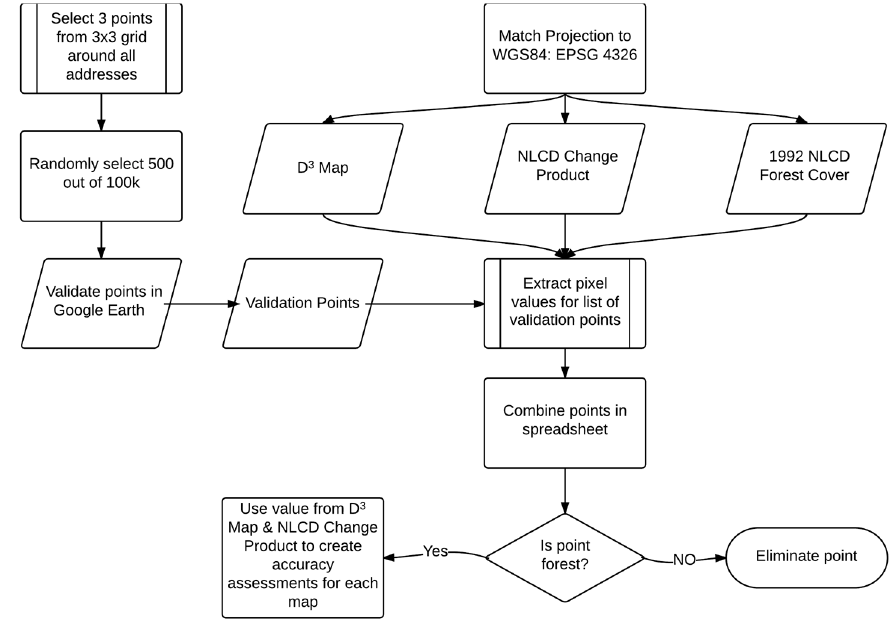
Figure 5. Process with which points were selected for the accuracy assessments.